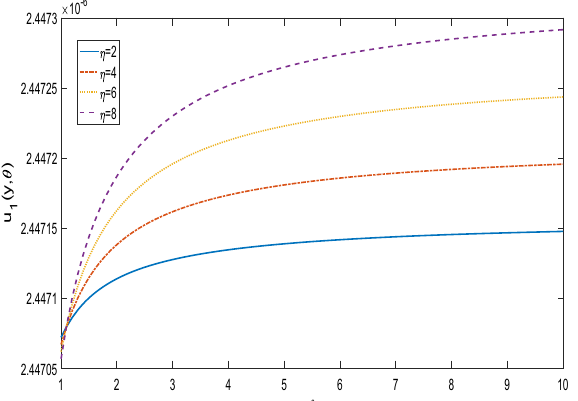
Fig. 2 Graphical representation of the dimensionless piezometric head w.r.t. dimensionless time for ζ = 10, and η = 2, 4, 6, 8 at distance y = 5.5 and fractional order α = 0 . 90 , β = 0 . 90